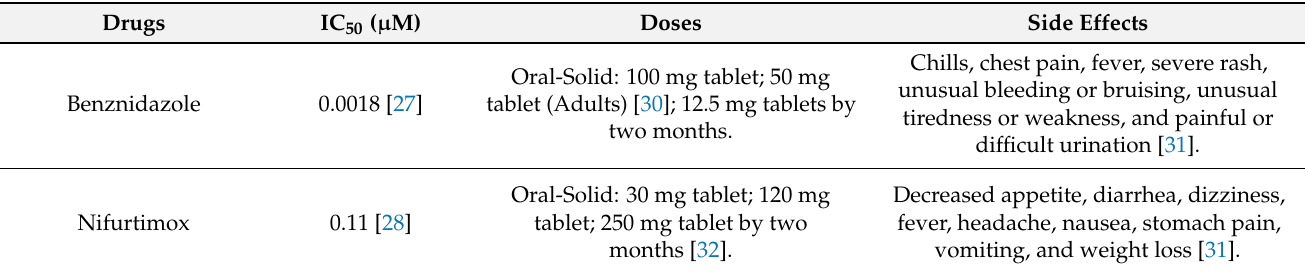
Table 1. Biological activity, dose, and adverse effects of drugs used against Chagas disease.